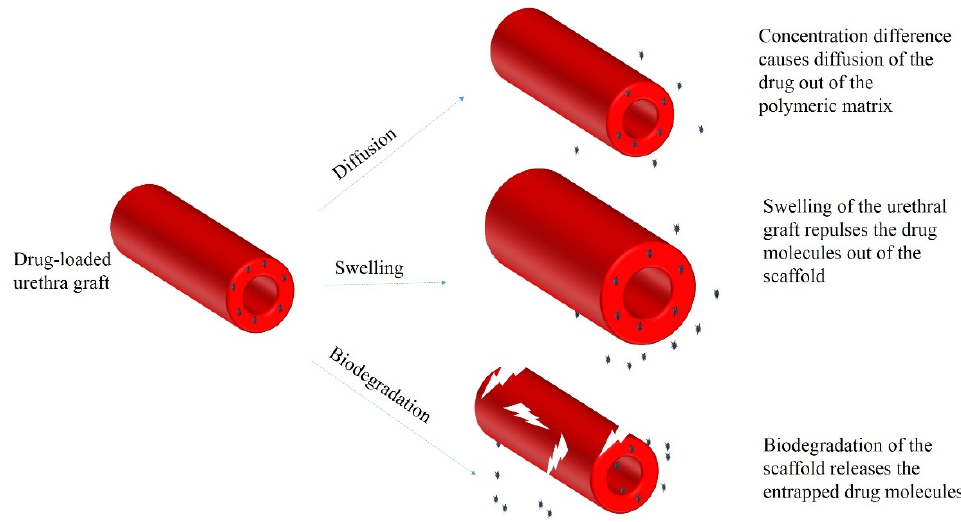
Figure 4. Schematic illustration representing the mechanisms involved in drug release from polymeric urethra grafts.